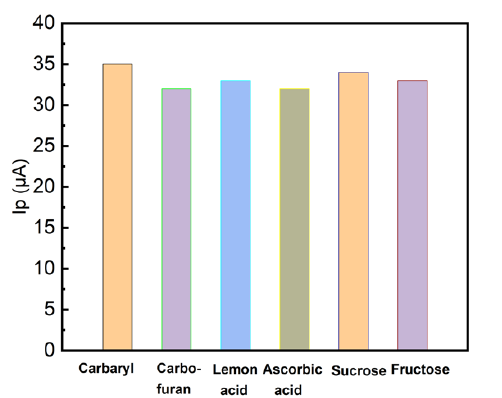
Figure 9. LSV anodic peak height of carbaryl (16 mg/L in 96% ethanol and deionized water (1:1)) at LRGO grid electrode. Adsorptive accumulation for 10 min in PBS (pH 6.86) containing carbaryl in the absence and presence of 10-fold concentration of carbofuran, citric and ascorbic acids, sucrose and fructose, respectively. The scan rate 300 mV/s.